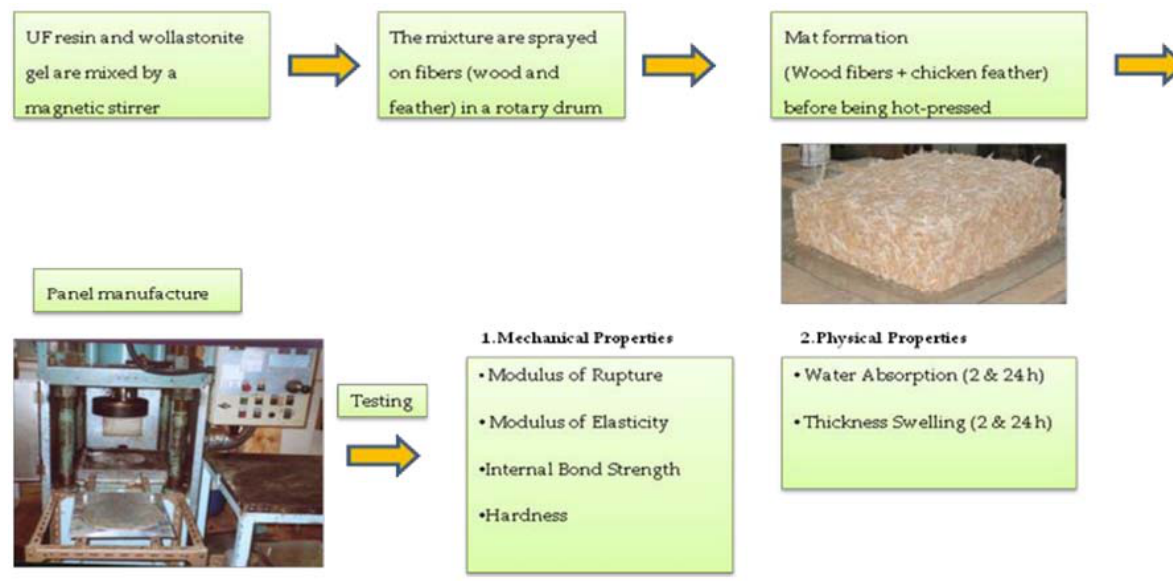
Figure 9. Flow diagram of the experimental procedure for the preparation of the wood panel reinforced with chicken feathers fibers. Reprinted from [44] with permission of MDPI.